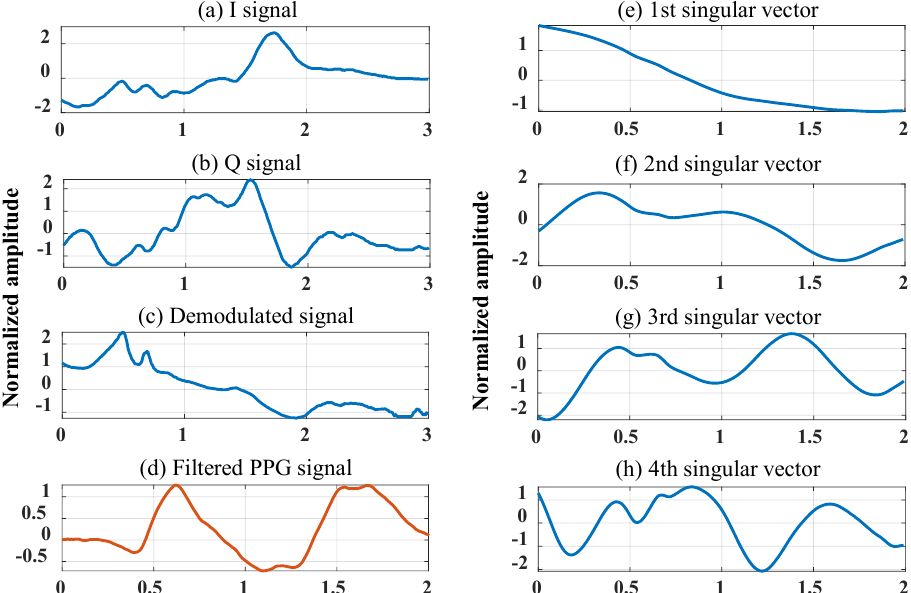
Figure 8. Examples of singular vector generation: ( a , b ) represent baseband signals from 24 GHz CW-DRS, ( c ) is the demodulated waveform by Arctangent, ( d ) shows the filtered PPG signal as a reference of the heartbeat, and ( e – h ) are the singular vectors of the trajectory matrix created from ( c